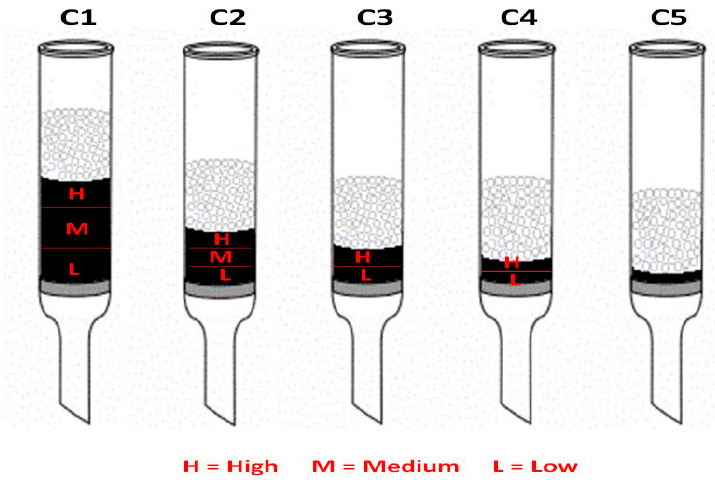
Figure 7. Samples taken in the different layers of MWCNTs. A comparison between the different TG curves of samples was possible. A TG curve of the pure RB5 dye is presented in Figure